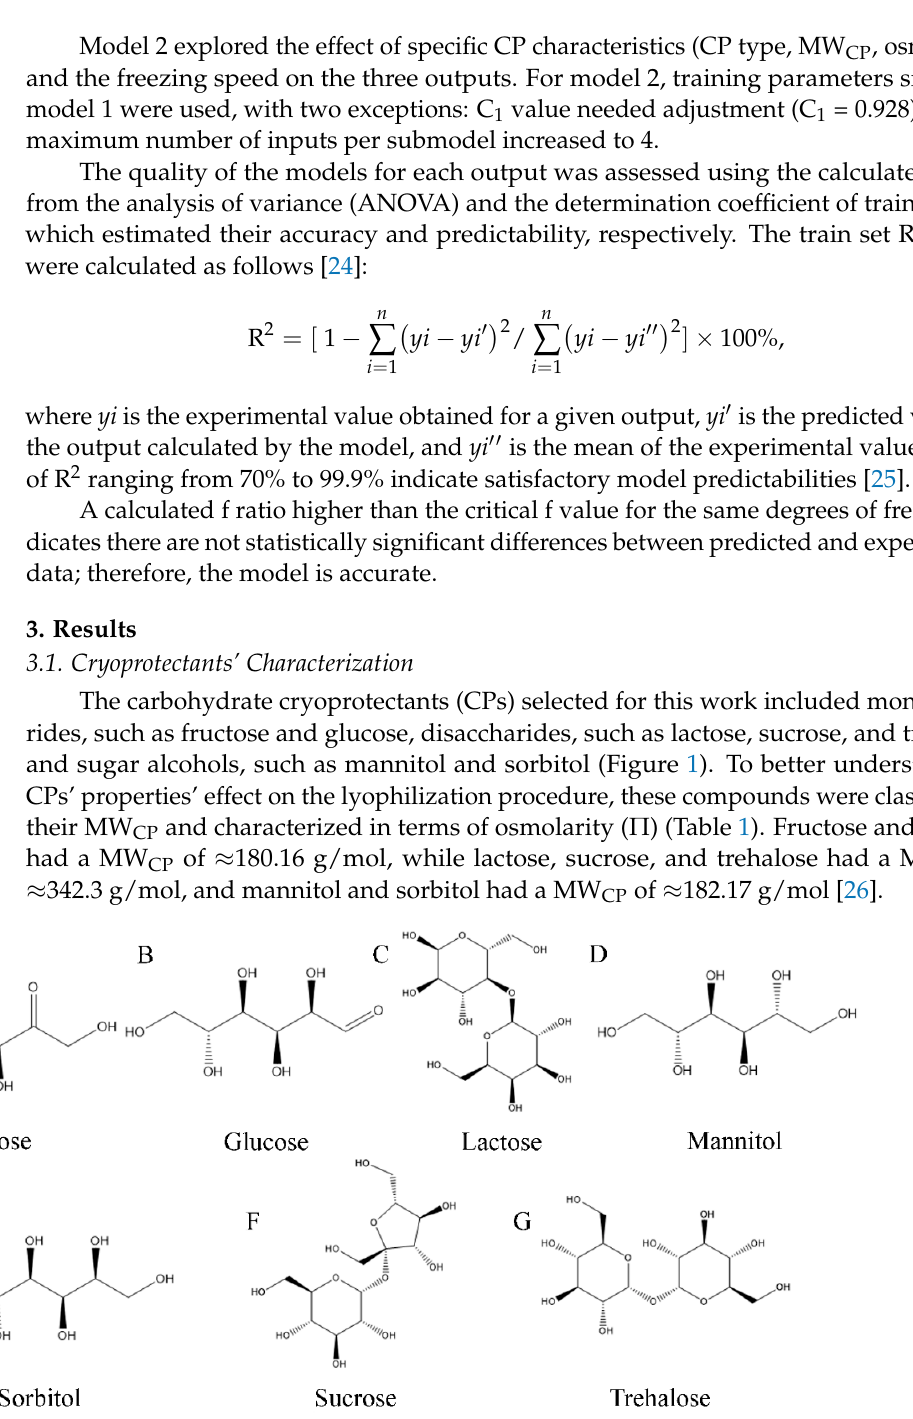
Figure 1. Chemical structure of ( A ) Fructose, ( B ) Glucose, ( C ) Lactose, ( D ) Mannitol, ( E ) Sorbitol, ( F ) Sucrose, and ( G ) Trehalose.